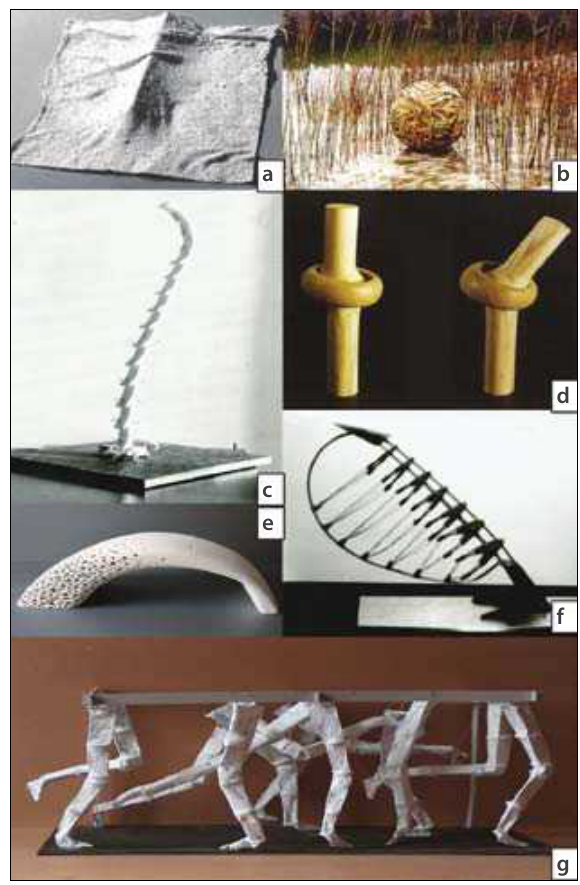
Fig. 3. Examples of students’ works. Initial study years: a – stu- dy of materials: structured and stiffened textile (VDA); b – stu- dy of materials. Exercises on a natural site. Study of modelling possibilities from ordinary natural materials; d – bionic study (VDA); c, e, f – bionic study (VGTU); g – sculptural modelling